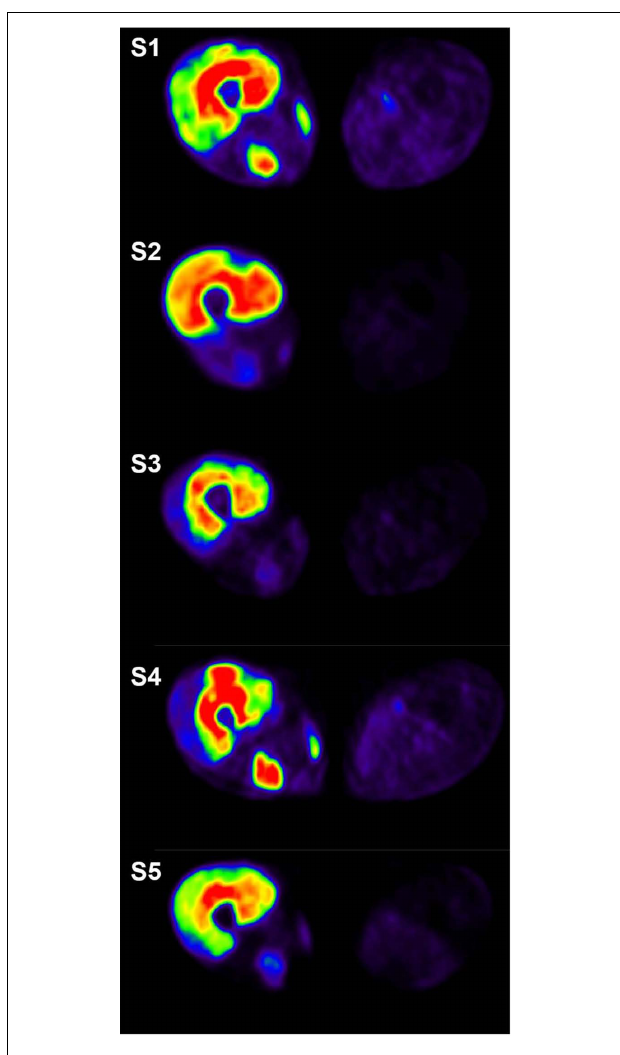
FIGURE 1 | Cross-sectional positron emission tomography images taken from the mid-thigh immediately after 35min of dynamic knee-extension exercise. [ 18 F]-fluoro-deoxy-glucose ([ 18 F]-FDG) was injected after 10min of exercise and the image reflects cumulated activity during the period 10–35min of exercise. Red color depicts the highest activity followed by yellow, green, and blue. Image from each subject is shown in different absolute scale to best visualize the relative individual differences in the different